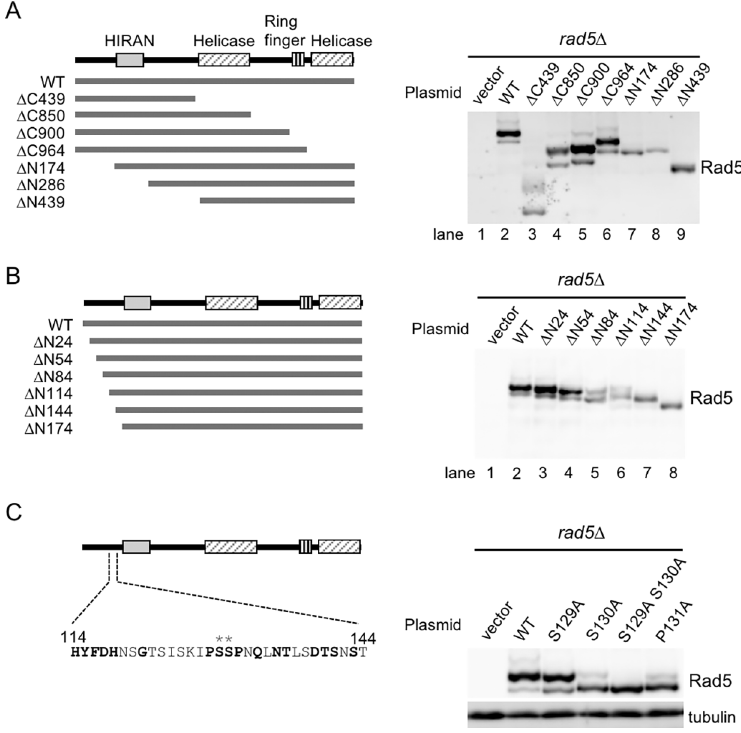
Fig 2. Identification of phosphorylation sites in Rad5. (A) Schematic representation of the Rad5 domains, including the HIRAN (176–285), helicase (440–848 and 1030–1164) and RING finger (913–961) domains, which are shown in the left panel. N- and C-terminal truncations of Rad5 shown in the left panel were constructed by fusion to a Myc epitope tag. rad5 Δ cells were transformed with each of the CEN/ARS plasmids carrying wild-type or truncated alleles of RAD5 .Expression of wild-type and truncated alleles from the endogenous RAD5 promoter was confirmed by Phos-tag western blotting using c-Myc antibody (right panel). (B) N-terminal truncations ranging in size from 24 to 174 residues, shown in the left panel, were constructed by fusion to a Myc epitope tag. Expression of truncations was examined as described in (A) (right panel). (C) Phosphorylation state of Rad5-Myc with each single or double amino acid substitutions in the N-terminal region. A map of the Rad5 N-terminal region between amino acids 114 and 144 is shown in the left panel. Asterisks indicate the putative phosphorylation sites, S129 and S130. rad5 Δ cells were transformed with plasmids carrying each rad5 mutant. Conserved amino acid residues among budding yeast are shown in bold. Phosphorylation patterns were analyzed as described in (A) (right panel). Tubulin served as a loading